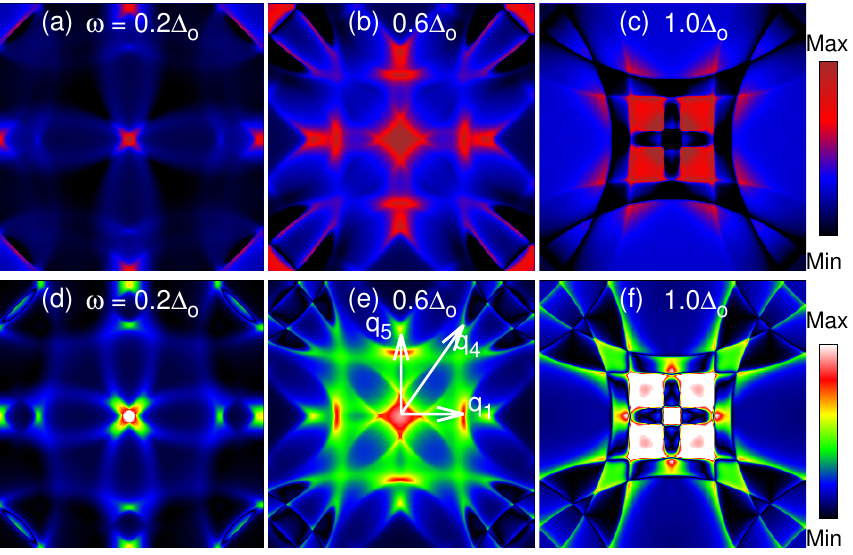
Figure 2: (a-c) g -maps and (d-f) z -maps for the quasiparticle energies in steps of 0.4 ∆ when the impurity atom is magnetic. The patterns have enhanced features o corresponding to the scattering vectors q